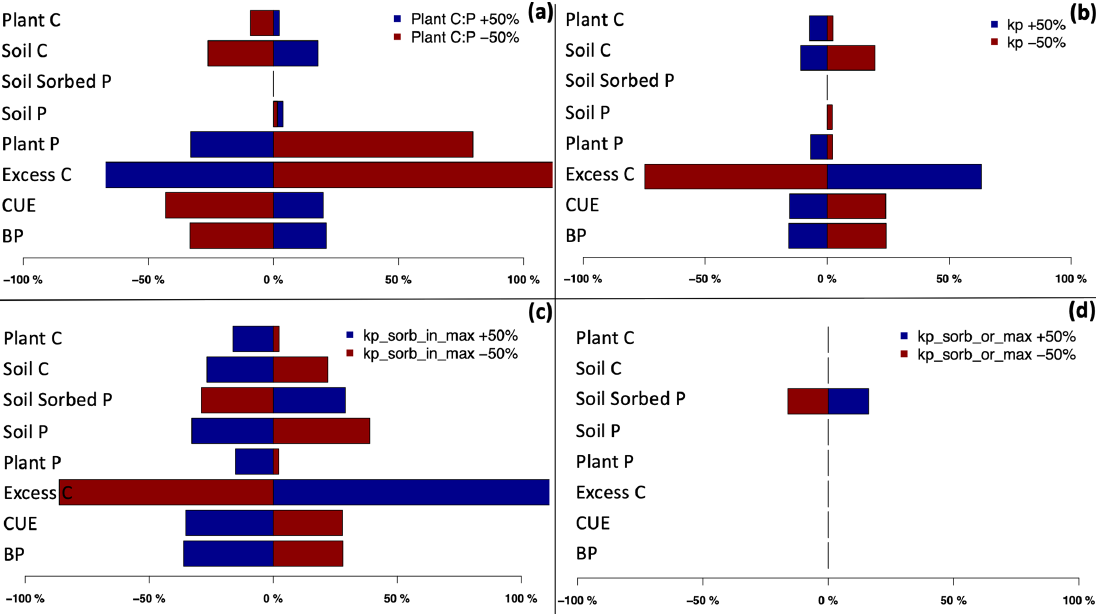
Figure 5. Sensitivity of C and P pools to variation in key model parameters: prescribed tissue C : P (a) , Kp (b) , Kp_sorb_in (c) , and Kp_sorb_or (d) under ambient CO 2 . Table 8. Simulated C pools and fluxes with JULES-C and JULES-CN and the difference between them and JULES-CNP (in percent) under eCO 2 . A positive percentage means larger respective values simulated with JULES C and JULES CN than with JULES-CNP (between